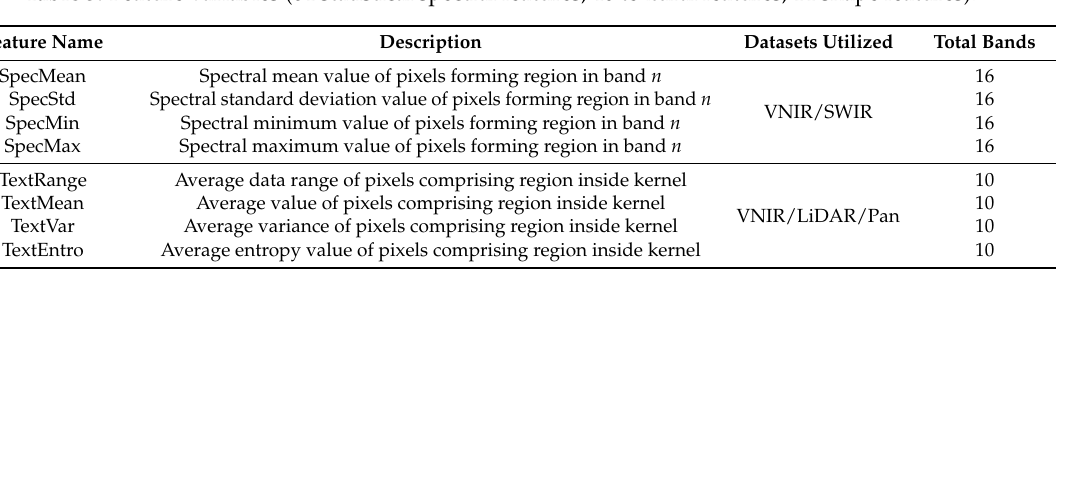
Table 3. Feature variables (64 statistical spectral features, 40 textural features, 14 shape